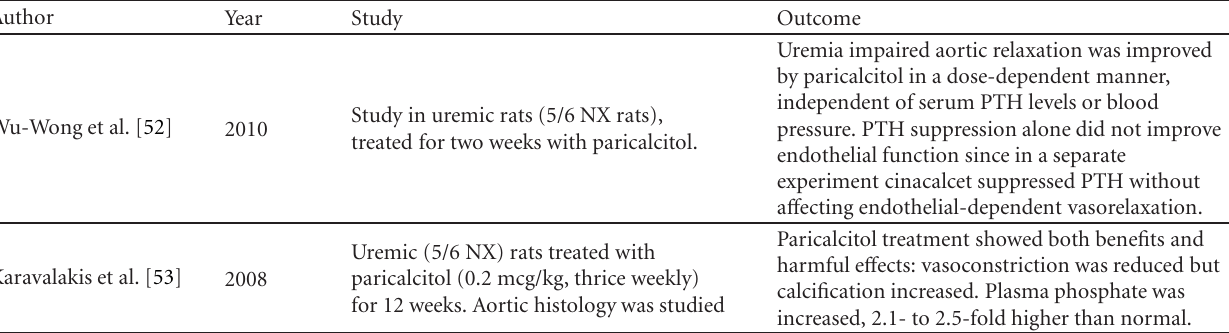
Table 14: Endothelial